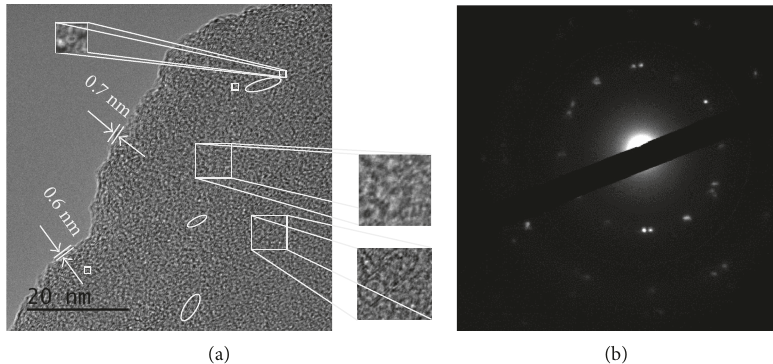
Figure 5: (a) HRTEM image of a dried lightest fraction of graphene suspension obtained from the decanted liquid substance after graphene- containing colloid sedimentation during 12hrs (Gr 0 ). Inset is a magnified part of the image taken from the regions enclosed by the white squares (not to scale); it shows graphene hexagons. The ovals note 1- and 2-layer graphene flakes. (b) Electron diffraction pattern.